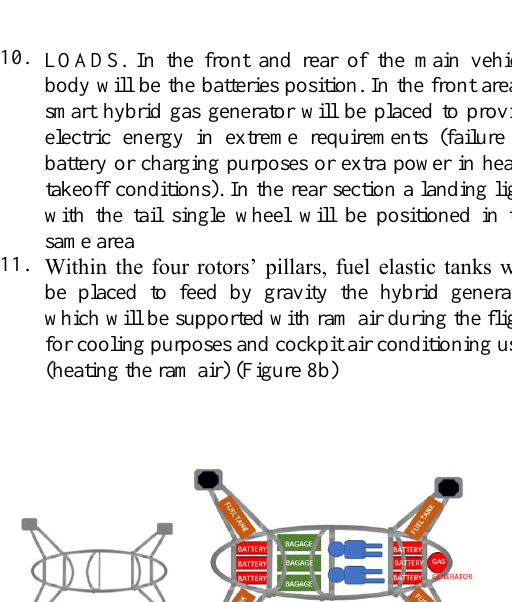
Figure 10 .Forces acting on